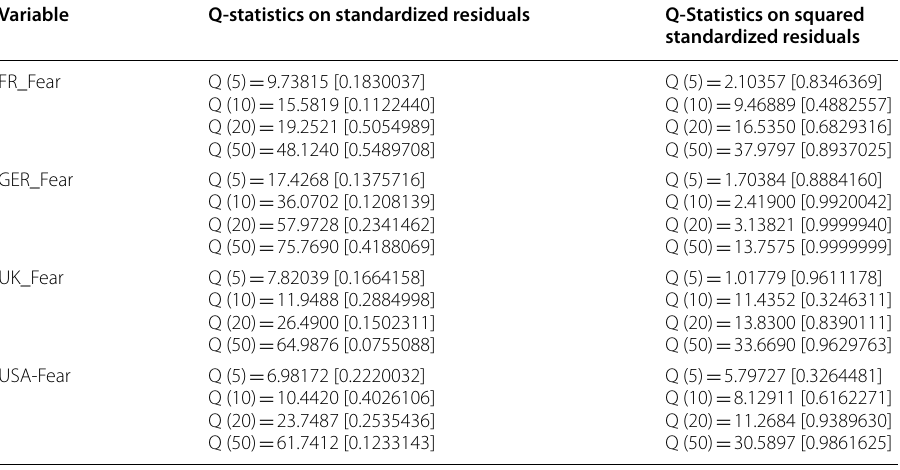
Table 7 Univariate tests of residuals correlation